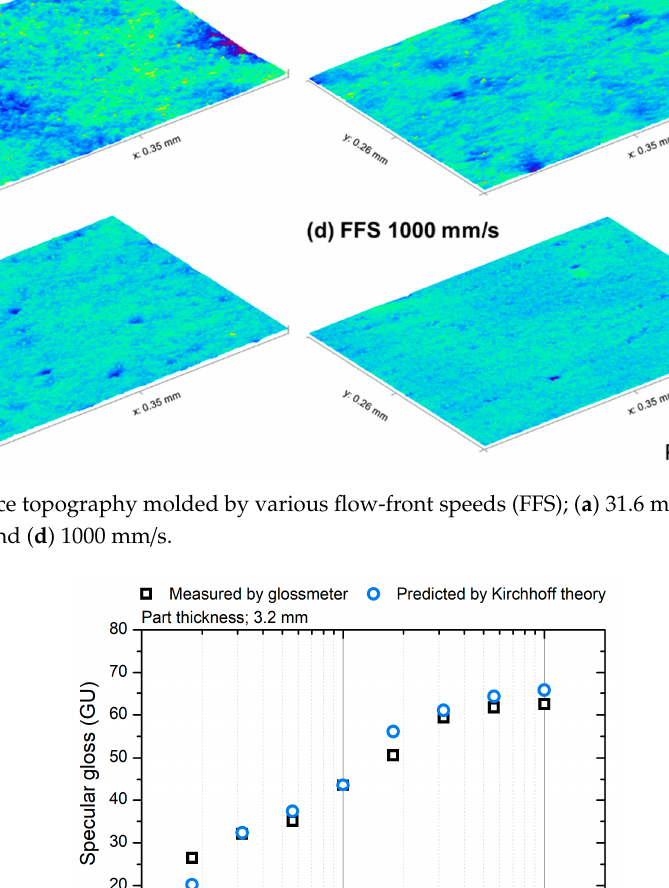
Figure 7. Surface topography molded by various flow-front speeds (FFS); ( a ) 31.6 mm/s, ( b ) 100 mm/s, ( c ) 316 mm/s, and ( d ) 1000 mm/s.